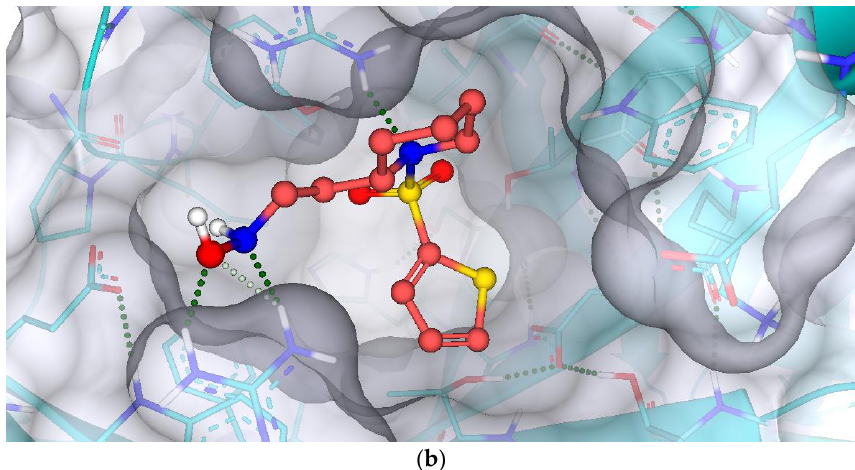
Figure 7. Docking complexes of compound c ( a ) and compound f ( b ) on the basis of highest affinities, minimum binding energies, no or minimum torsions, and the absence of any intra- and inter- molecular clashes.